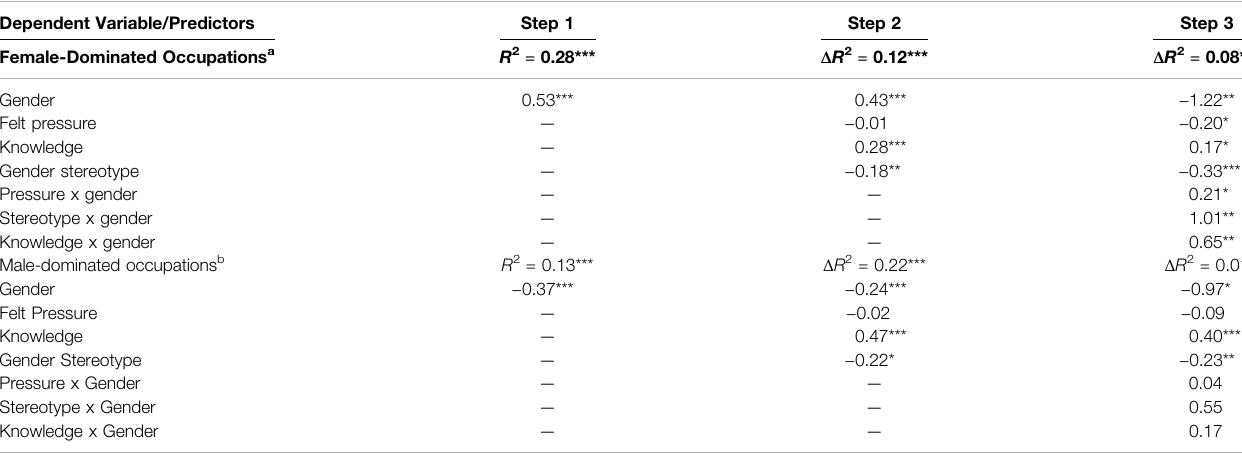
TABLE 3 | Hierarchical linear regression model predicting occupational interest.